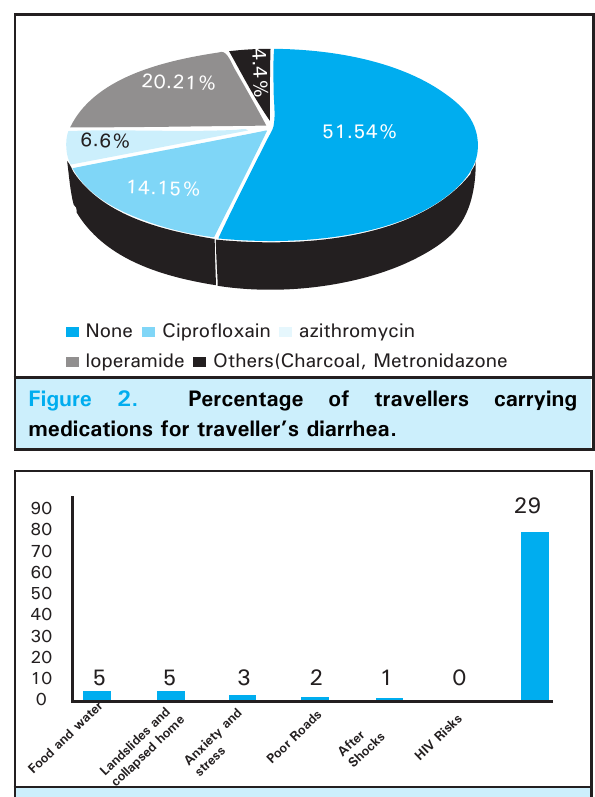
Figure 3. Perceived risk among volunteers.